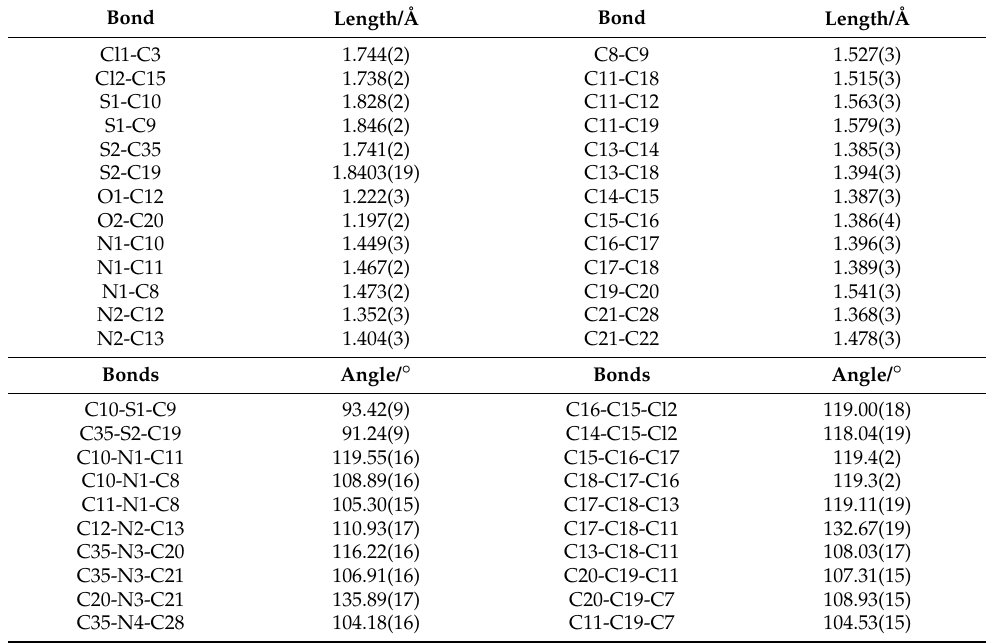
Table 3. Bond lengths (Å) and angles ( ◦ ) for 4